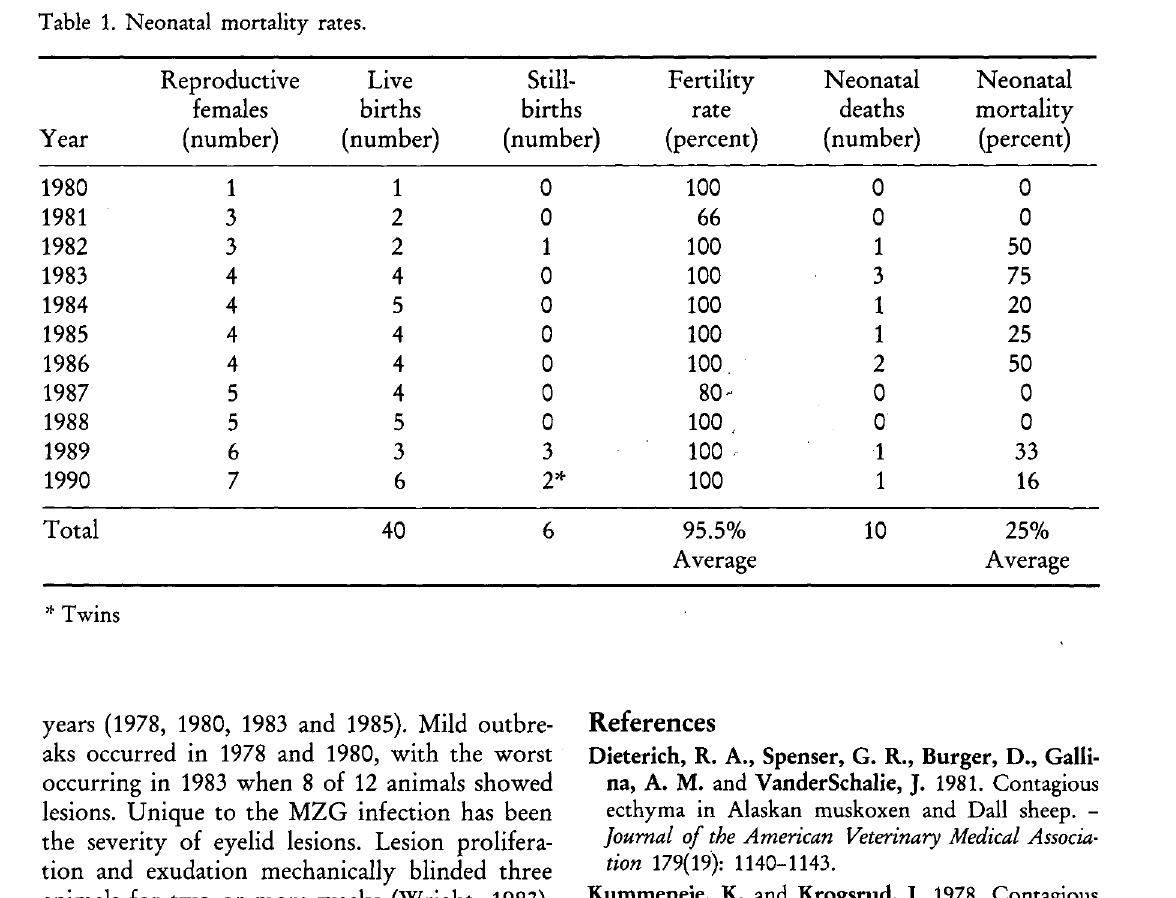
Table 1. Neonatal mortality